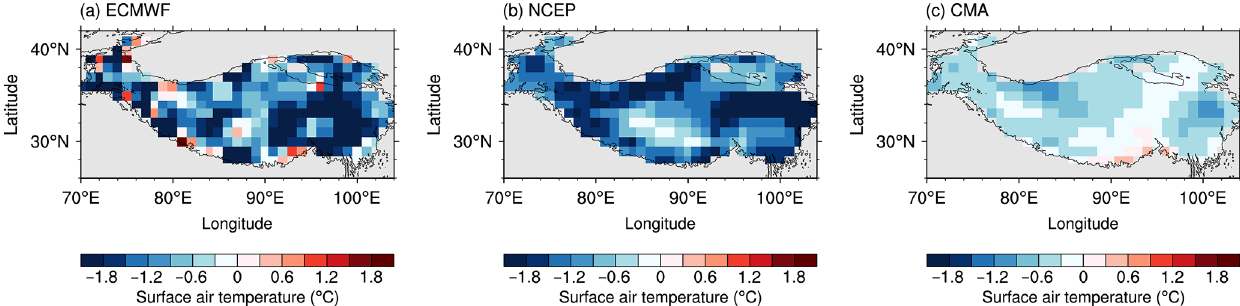
Figure 9. Differences in the multiyear wintertime mean surface air temperature over the Tibetan Plateau (unit: ◦ C) between forecasts with a lead of 4 weeks and forecasts with a lead of 1 week in (a) ECMWF, (b) NCEP and (c) CMA. The map of the Tibetan Plateau was created by using Global Relief Model data of ETOPO1 (topographic data free to the public, https://doi.org/10.7289/V5C8276M, National Geophysical Data Center, 2020).